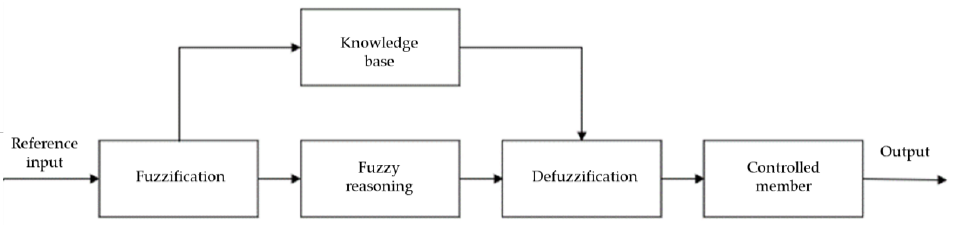
Figure 5. Basic structure of fuzzy control.